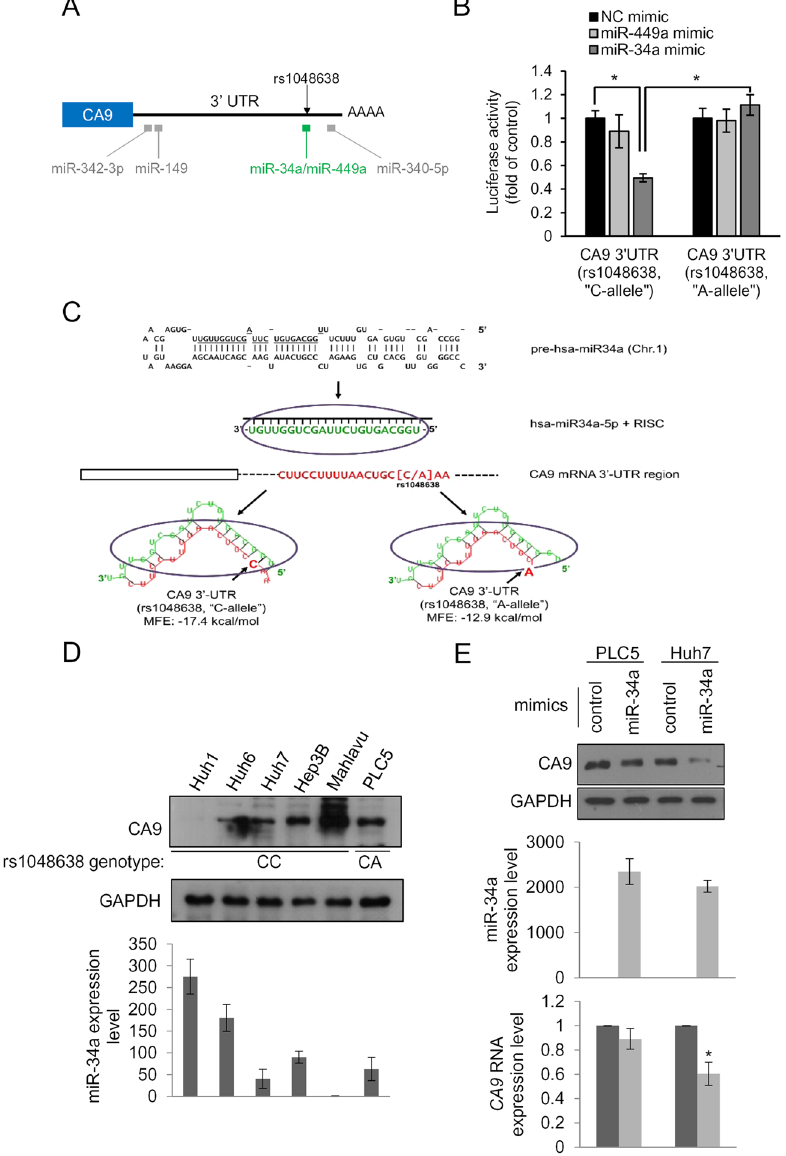
Figure 2. The CA9 polymorphism determines the response to miR-34a targeting. ( A ) Schematic illustration of miRNA target sites and the rs1048638 position on the CA9 3 ′ untranslated region (UTR). ( B ) CA9 3 ′ UTR reporters were transfected with the indicated miRNA or scrambled control (NC) mimics into 293T cells. Luciferase activities were measured and are shown as multiples of the control. ( C ) A minimum free energy (MFE) analysis of the alignment between miR-34a and the CA9 3 ′ UTR with an “A’ or “C” allele at rs1048638. ( D ) Upper panel: Western blot analysis of CA9 in HCC cell lines. The rs1048638 genotype of each cell line is labeled below the blot. Lower panel: Quantitative analysis of miR-34a levels in HCC cell lines. Data are presented normalized to the miR-34a level of Mahlavu cells. ( E ) Upper panel: Western blot analysis of CA9 in PLC5 and Huh7 cells transfected with miR-34a or the control mimic, respectively. miR-34a expression levels are shown in the middle panel. CA9 RNA expression levels are shown in the lower panel. Three independent replicates were performed in each experiment. Error bars, ± S.D. * p < 0.05 by a two-sided Student’s t -test. GAPDH was used as a loading